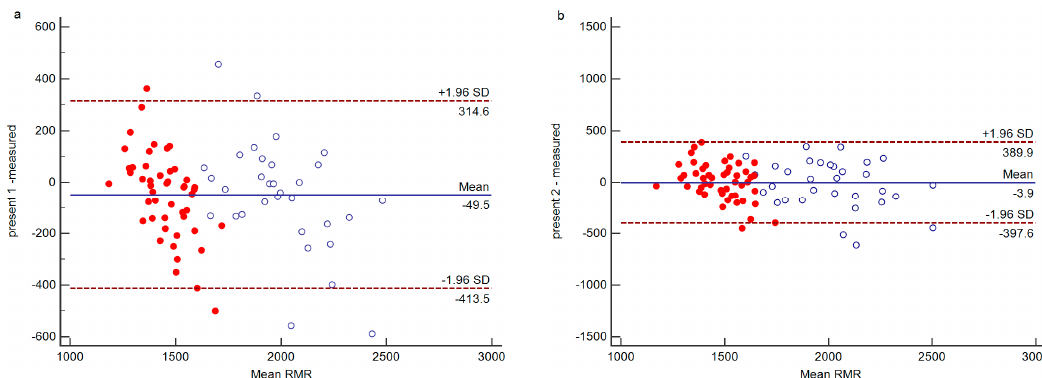
Figure 1. Bland–Altman plot for RMR between present equations (( a ) Present 1, ( b ) Present 2) and indirect calorimetry (IC) data ( n = 80). Solid horizontal line presents mean di ff erence between the two methods in kcal / day. Dashed lines depict 95% limits of agreement (mean di ff erence ± 1.96 SD) in kcal / day. Solid circle: female, hollow circle: male.